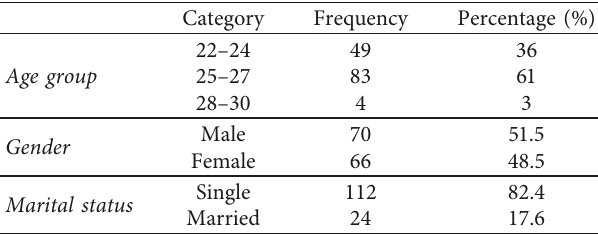
Table 1: Demographic data of medical students at Tehran Uni- versity of Medical Sciences.